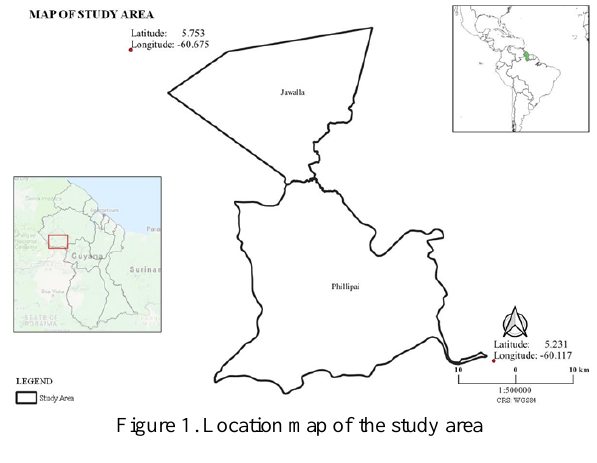
Figure 1. Location map of the study area